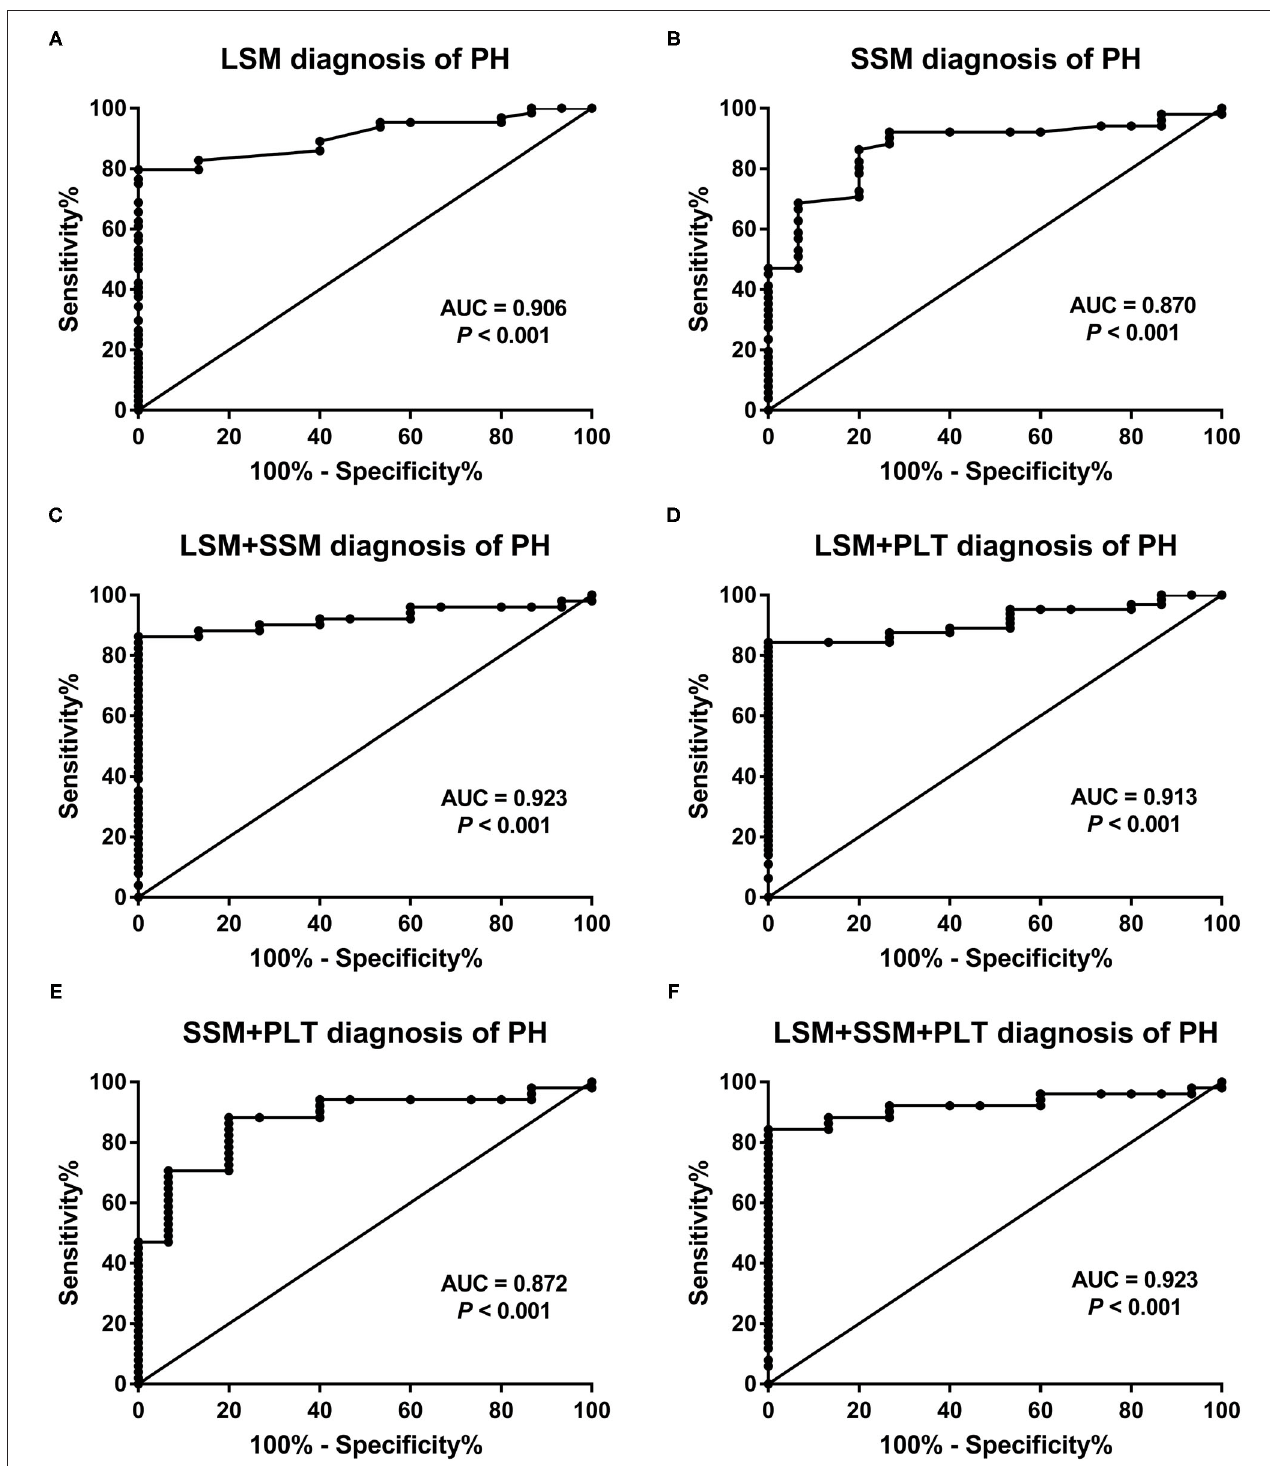
FIGURE 4 | Receiver operating characteristic curves of (A) LSM, (B) SSM, and (C–F) the four combined models for predicting portal venous pressure. AUC, area under the receiver operating characteristic curve; LSM, liver stiffness measurement; PH, portal hypertension; PLT, platelet count; SSM, spleen stiffness measurement.